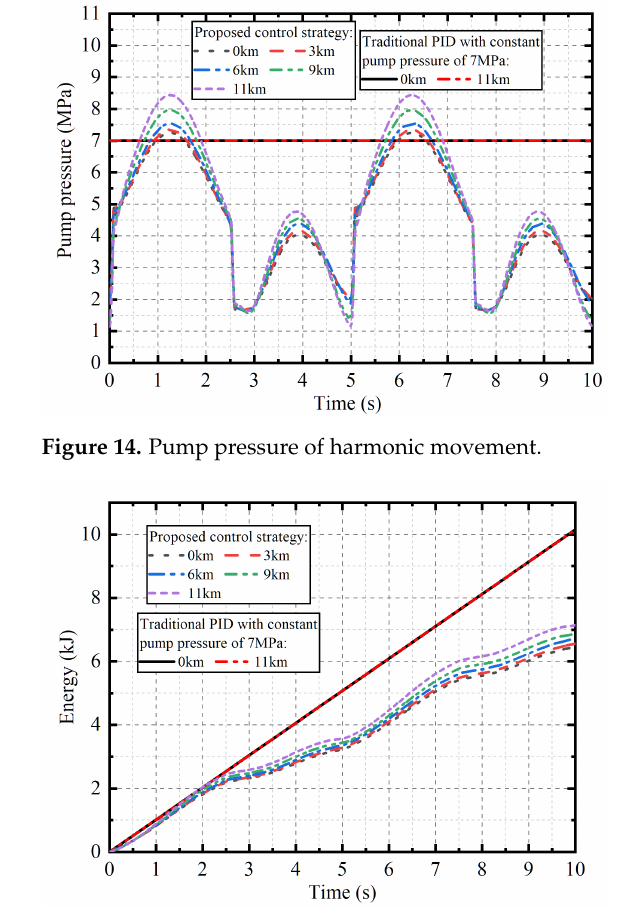
Figure 15. Energy consumption of harmonic